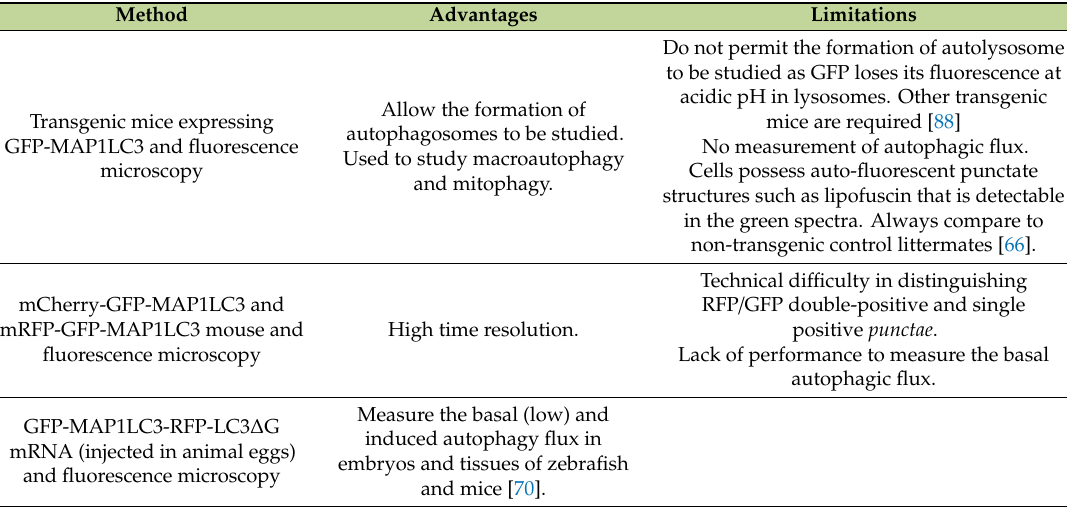
Table 5. Methods to measure autophagy in vivo 1,2